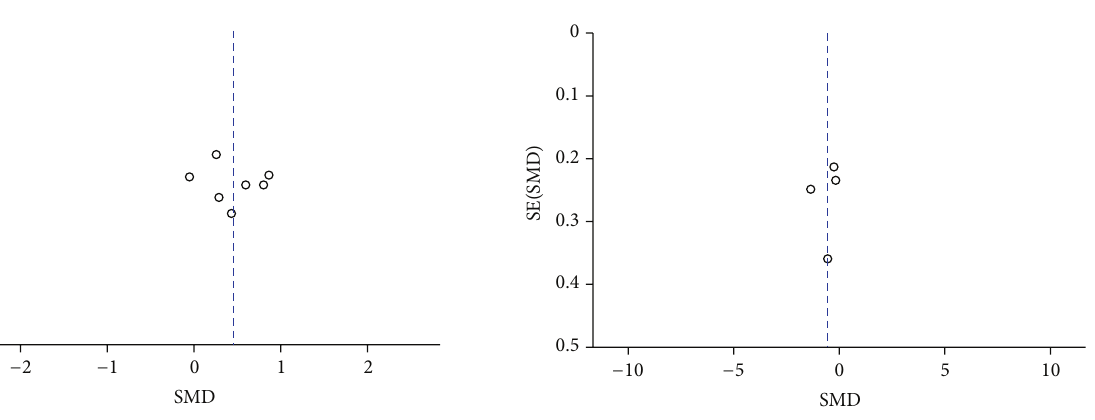
Figure 16: Funnel plot of CSF 𝛼 -syn levels in PD compared to PSP.